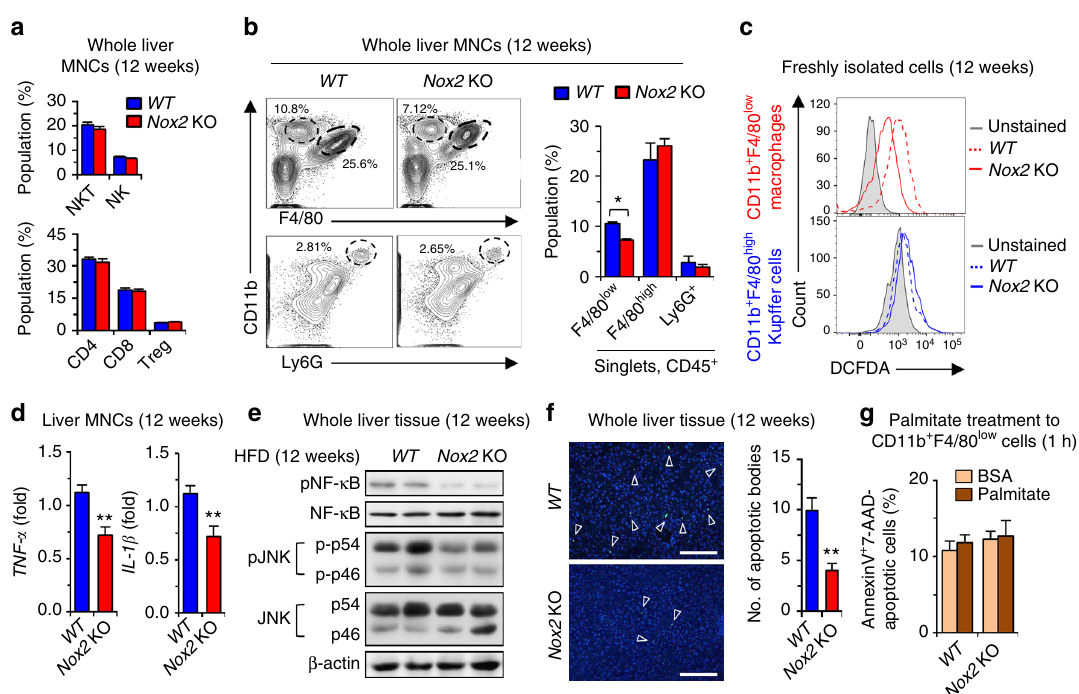
Fig. 2 NOX2 de fi ciency decreases in fl ammatory response in CD11b + F4/80 low macrophages in mice fed a high-fat diet. WT and Nox2 KO mice were fed a high-fat diet for 12 weeks. a , b Isolated whole liver MNCs were subjected to fl ow cytometry analyses. c The generation of ROS was monitored by DCF fl uorescence in freshly isolated CD11b + F4/80 high Kupffer cells and CD11b + F4/80 low macrophages. d , e Whole liver MNCs and tissues were subjected to qRT – PCR and Western blotting, respectively. f Apoptotic bodies were assessed and counted after TUNEL staining (average number of 5 fi elds under χ 200 magni fi cation). Bar = 200 μ m. g After treatment with palmitate for 1 h, CD11b + F4/80 low macrophages stained with Annexin V and 7-AAD were analyzed by fl ow cytometry. Data are representative of three independent experiments using 5 ( a – f ) and 3 ( g ) mice per group. Data are expressed as the mean ± s. e.m. and analyzed by Student ’ s t -test, ** P < 0.01 in comparison with the corresponding palmitate-induced signi fi cant internalization of TLR4 and NOX2 proteins from membrane fraction to cytosol, but a direct inter- action between TLR4 and NOX2 proteins was not observed (Fig. 5a). In addition, phosphorylation of NF- κ B and JNK (pNF- κ B and pJNK) and expression of Nlrp3 and Il-1 β mRNAs were increased by palmitate treatment, but these effects were absent in Nox2 - or Tlr4 -depleted RAW 264.7 cells (Fig. 5a; Supplementary Fig. 4a – d). In parallel, palmitate treatment induced not only caspase-1 activation but also increased expression of Il-1 β and Nlrp3 in WT bone marrow-derived macrophages (BMDMs), but